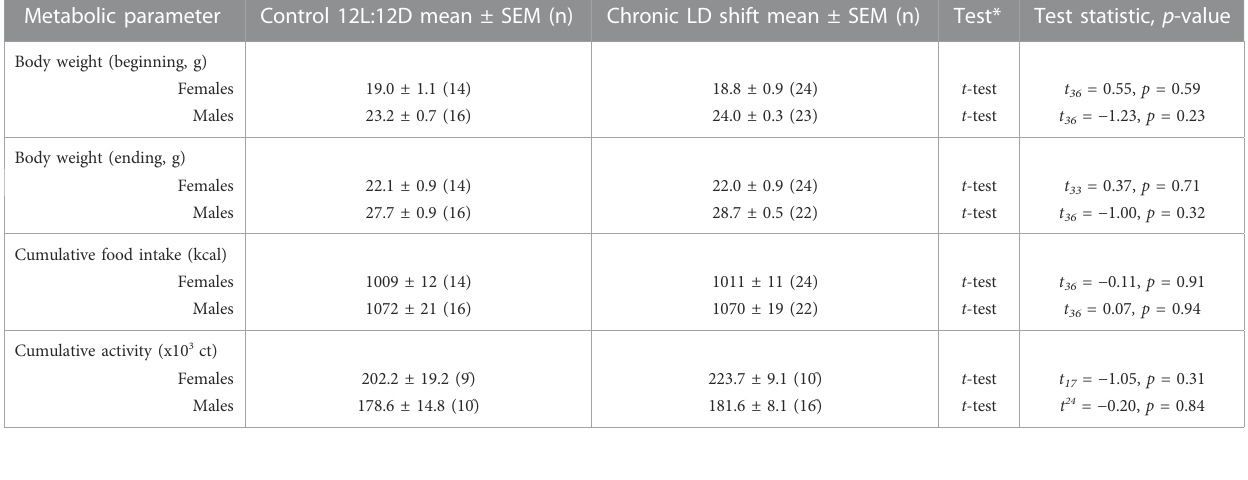
TABLE 2 Descriptive statistics and statistical analyses of metabolic parameters. Comparisons were made within the same sex for each parameter;*Tests were two- tailed; ^ Some mice removed from the activity analysis due to faulty infrared sensors.